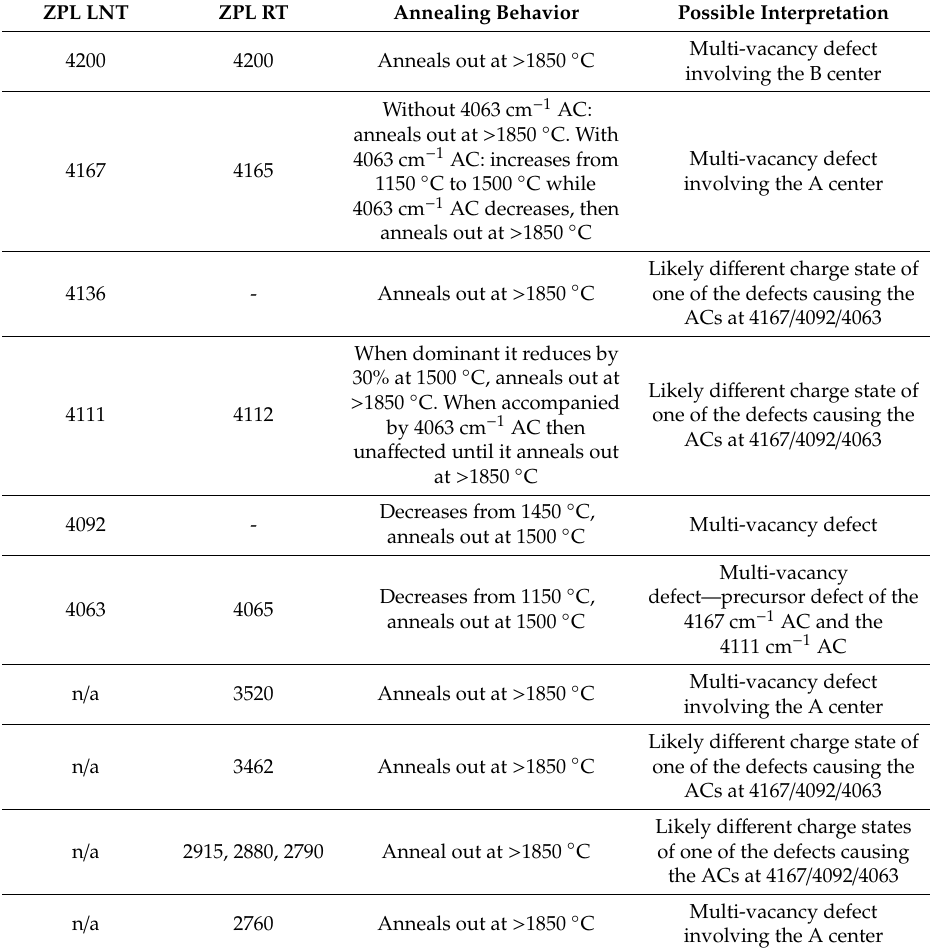
Table 3. The ZPL positions of the ACs, their annealing behavior in type I DR brown diamonds, and their possible